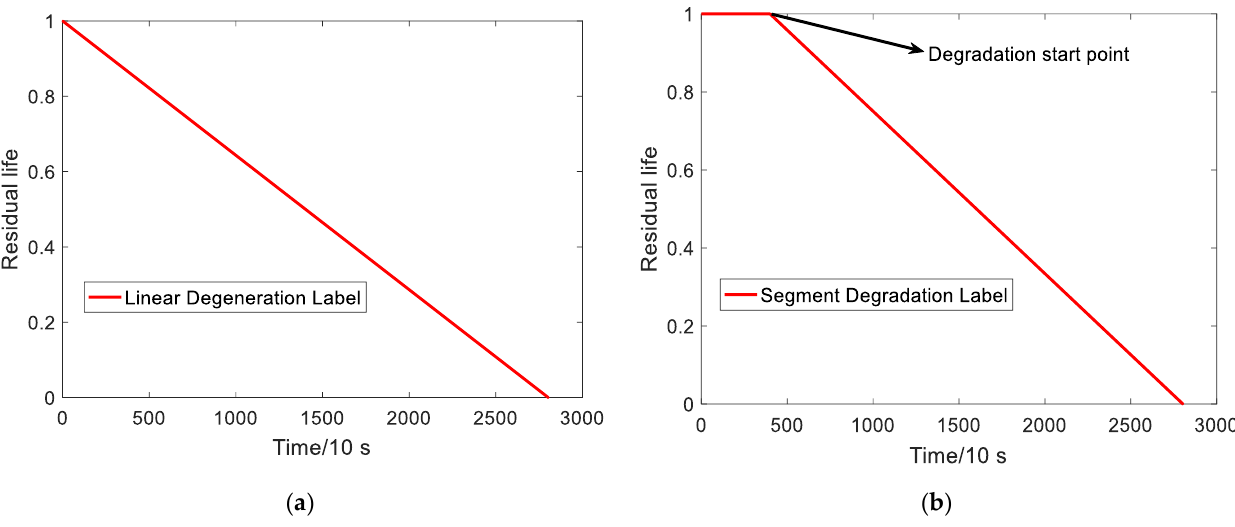
Figure 8. Two commonly used degradation labels. ( a ) Linear degeneration label; ( b ) Segment degradation label.